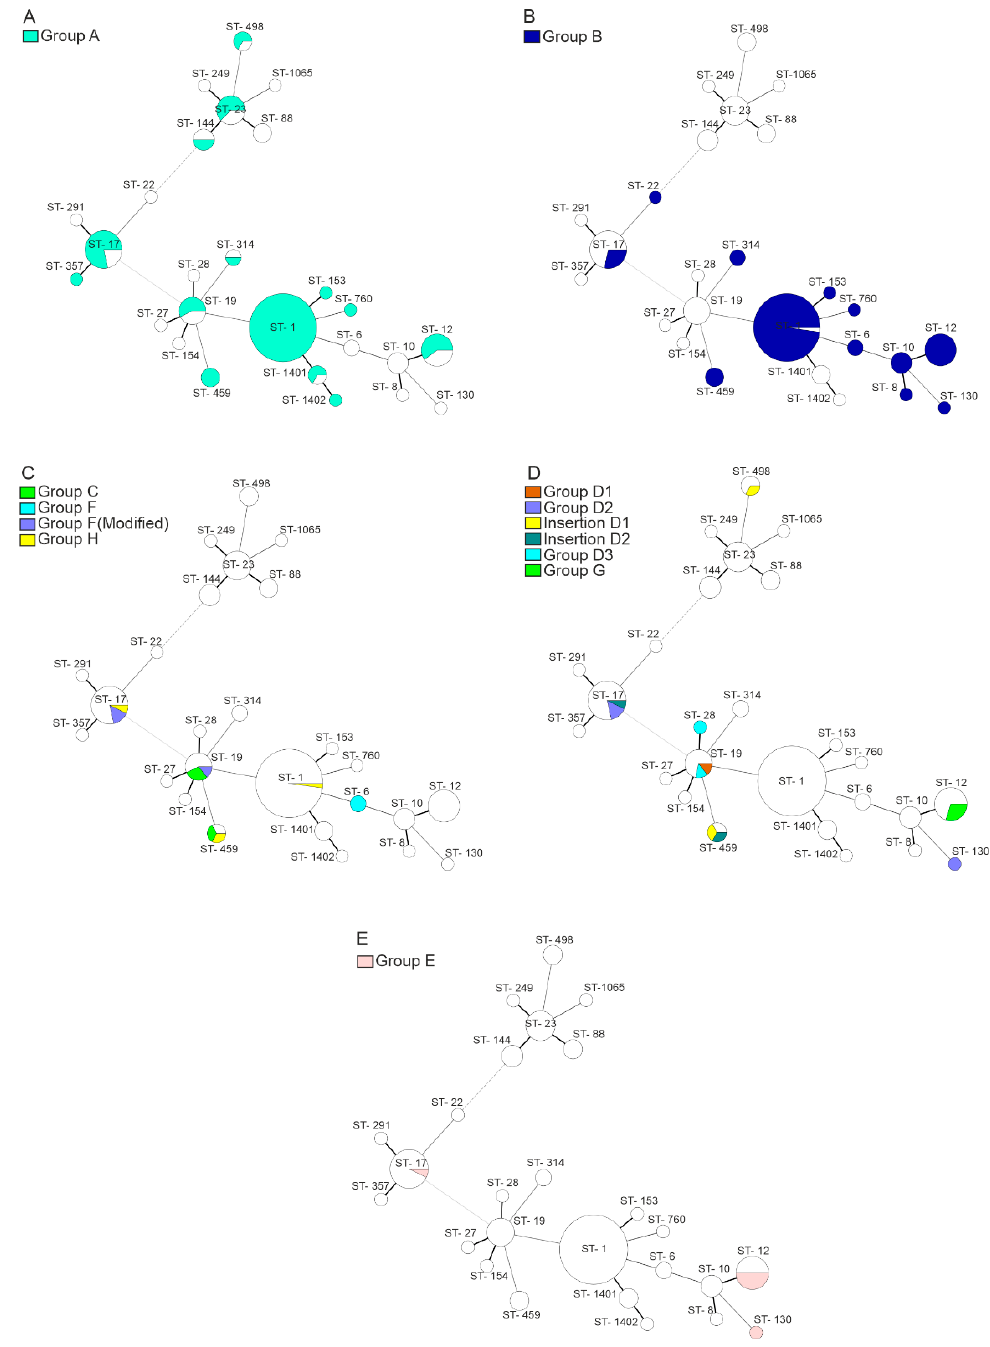
Figure 4. Distribution of prophage groups according to multi locus sequence typing (MLST) sequence types in 123 GBS strains: ( A ) group A; ( B ) group B; ( C ) related groups C, F and H; ( D ) related groups D and G; ( E ) group